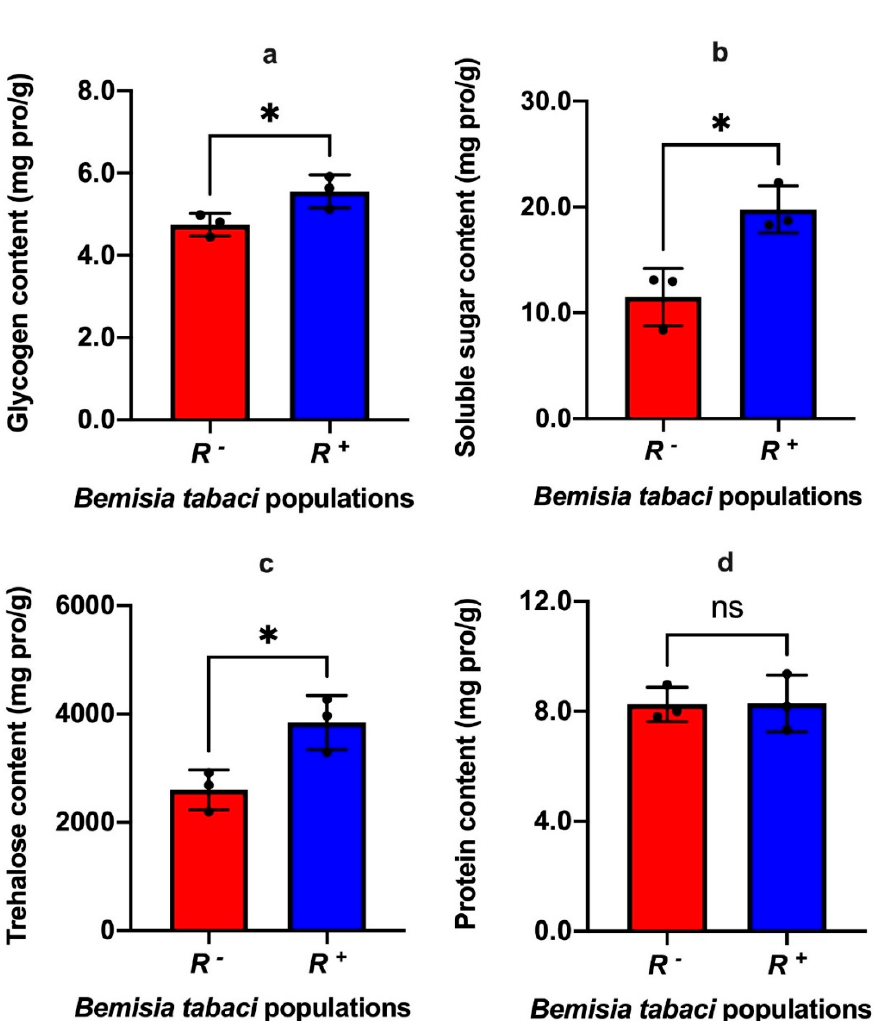
Figure 2. The effect of Rickettsia infection on the glycogen content ( a ), soluble sugar content ( b ), trehalose content ( c ) and protein content ( d ) of Bemisia tabaci MEAM1 cryptic species. R + : Rickettsia positive population, R − : Rickettsia negative population. Data were compared among treatments using t -test, and stars over the bars * signify differences were significantly different at 0.05 level respectively, ns signifies differences were not significant.